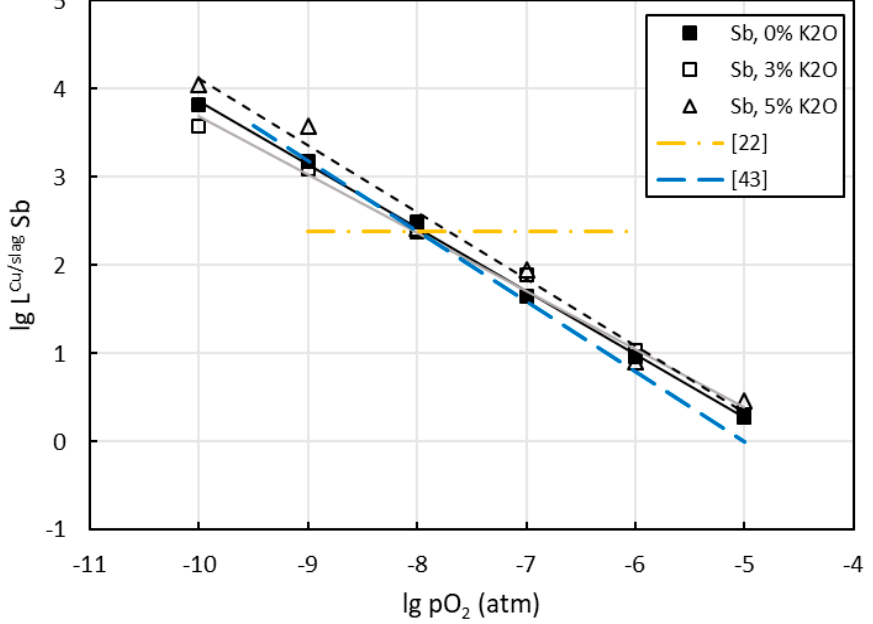
Figure 8. Distribution coefficient of antimony between copper alloy and different slags as a function of oxygen partial pressure. For the slags, LA-ICP-MS results were used below 10 − 6 atm pO 2 .